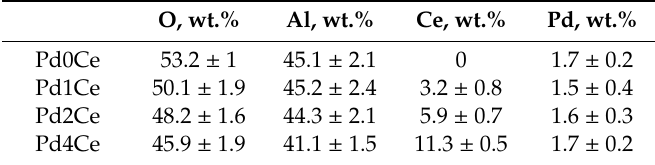
Figure 3. SEM-EDX analysis of Pd1Ce catalyst: ( A ) Al, ( B ) Ce, ( C ) Pd, and ( D ) Pd-Ce-Al.